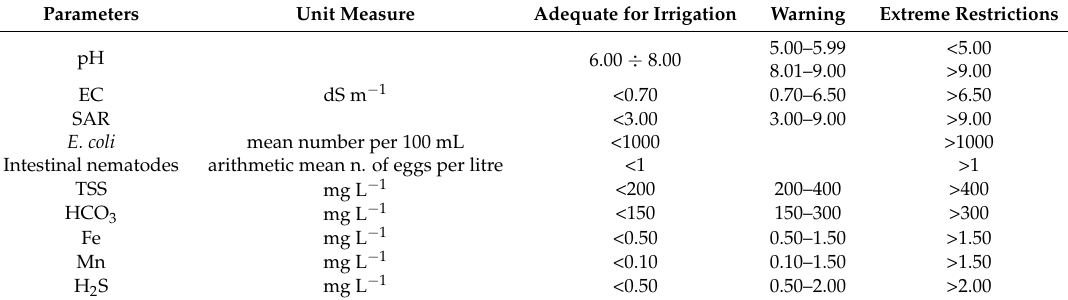
Table 1. List of parameters used in the Irrigation Water Quality Tool Threshold (IWQT) and their quality thresholds